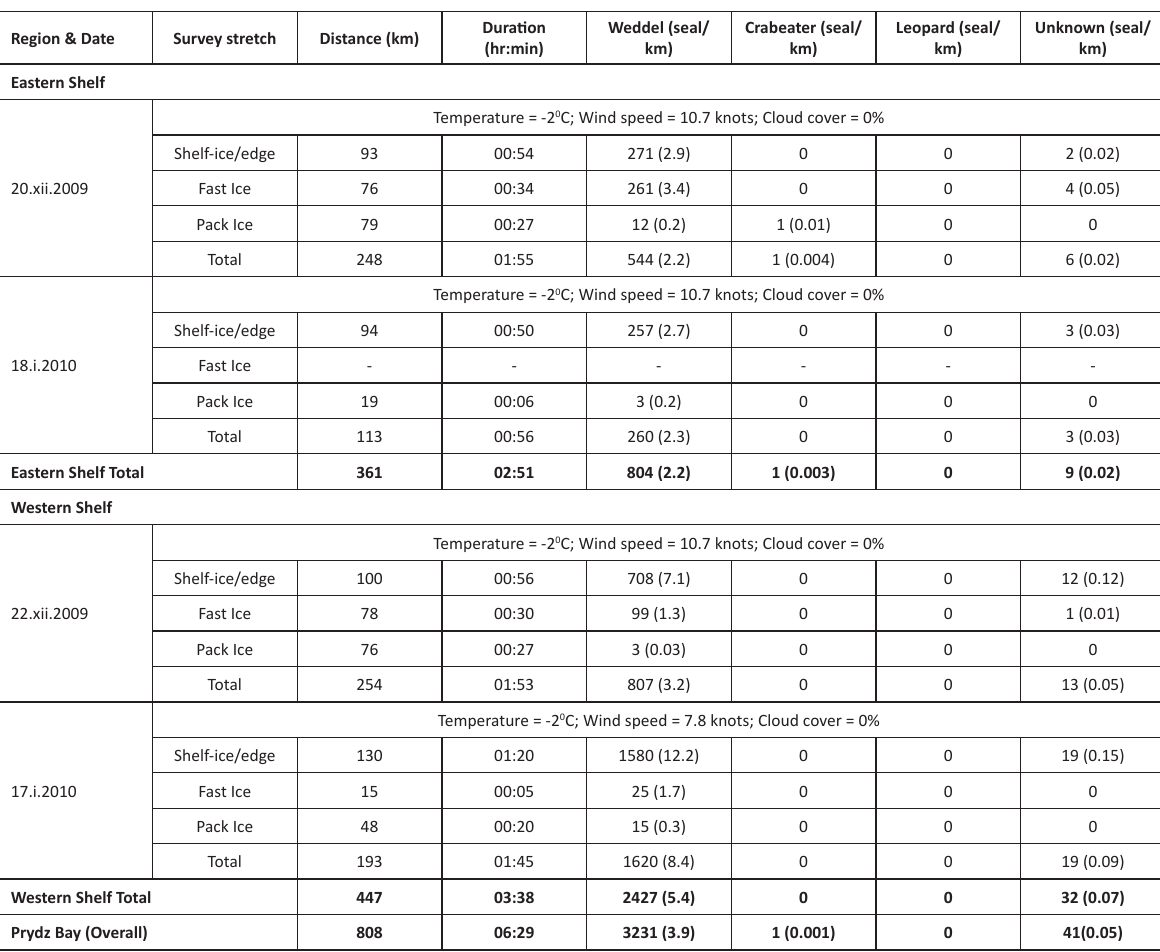
Table 1a. Details of the aerial survey for seals carried out in the Prydz bay during December 2009 and January 2010.